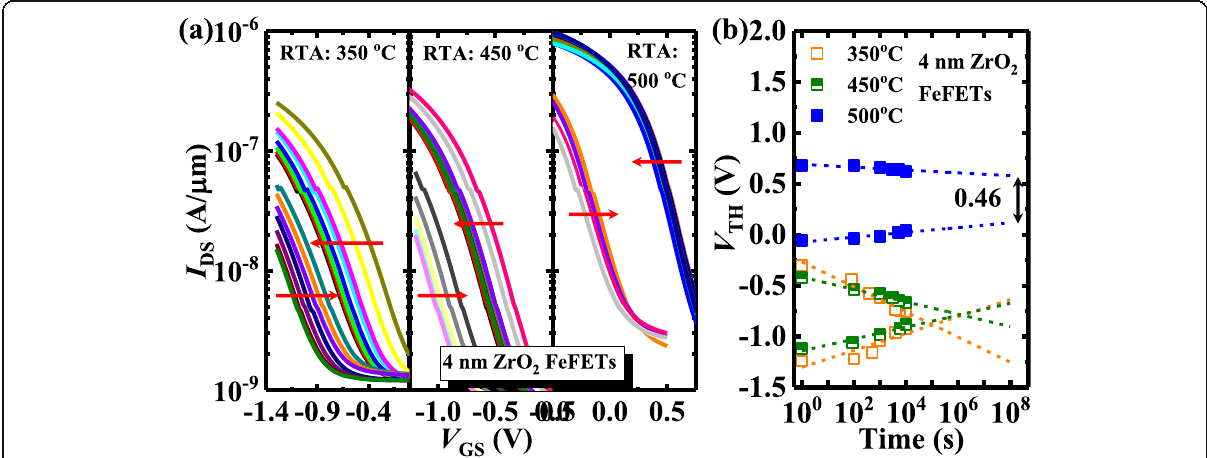
Fig. 8 a The evolution of I DS - V GS curves for the two polarization states of the 4 nm ZrO 2 FeFETs with different RTA temperatures. b The 4 nm